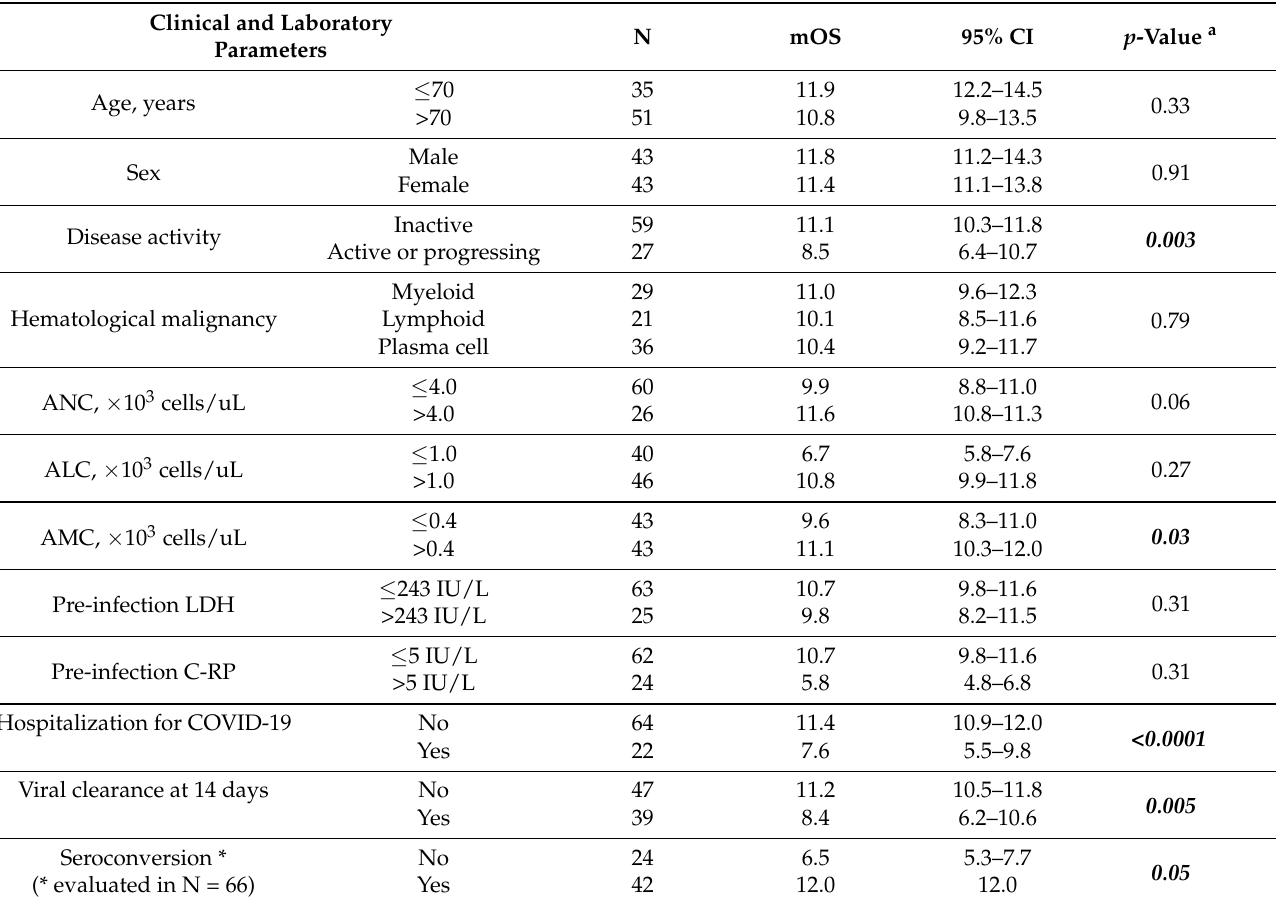
Table 5. Univariate analysis of median overall survival based on main pre-infection clinical and laboratory parameters in unvaccinated hematological patients with COVID-19.